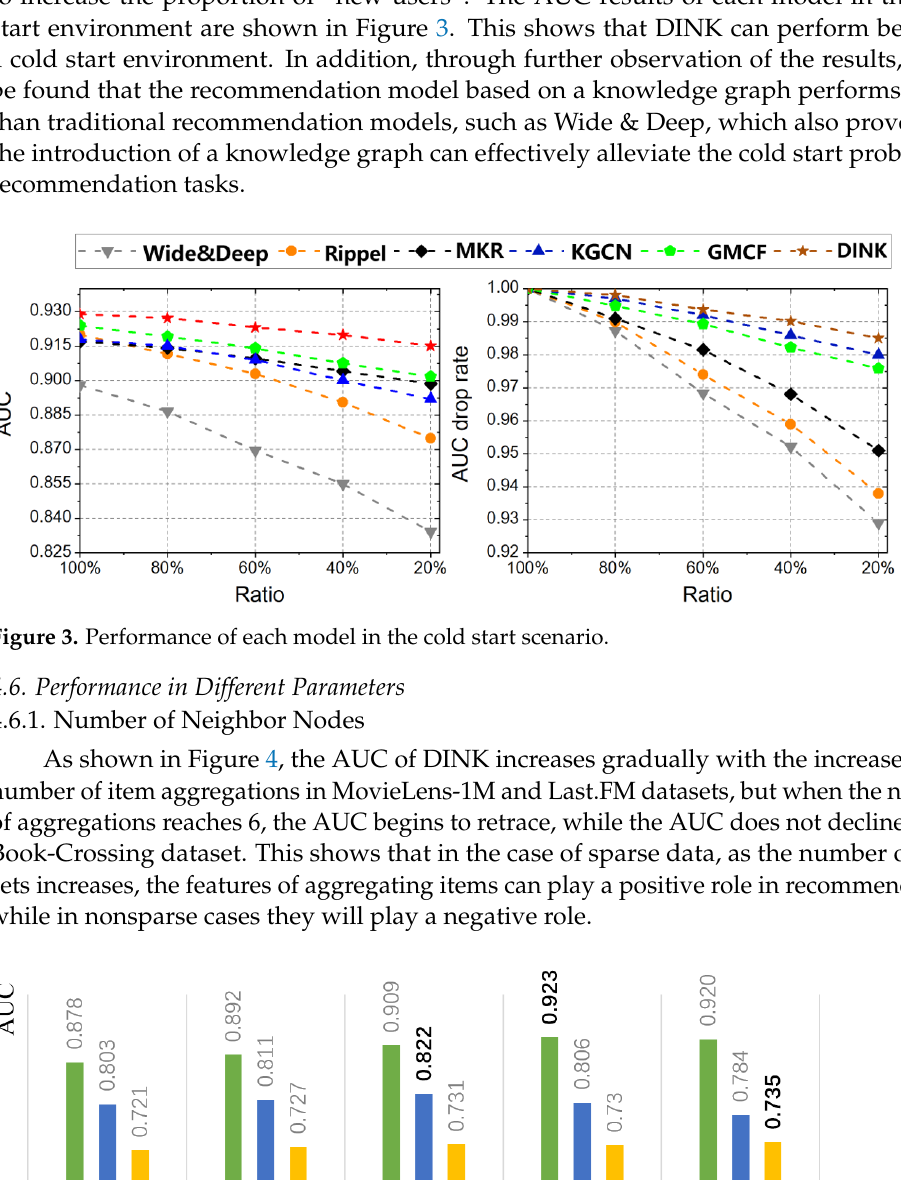
Figure 5. Performance in Different Lengths of Sequence. 4.6.3. Dimension of Embedding As shown in Figure 6, with the other parameters unchanged, the AUC of DINK in MovieLens-1M will gradually increase with increasing d-dimension and achieve the op- timal performance in the case of 64 dimensions. In the Last.FM and Book-Crossing da- tasets, the model achieves the best performance at 16 dimensions. However, as the dimen- sion increases, the performance gradually degrades.